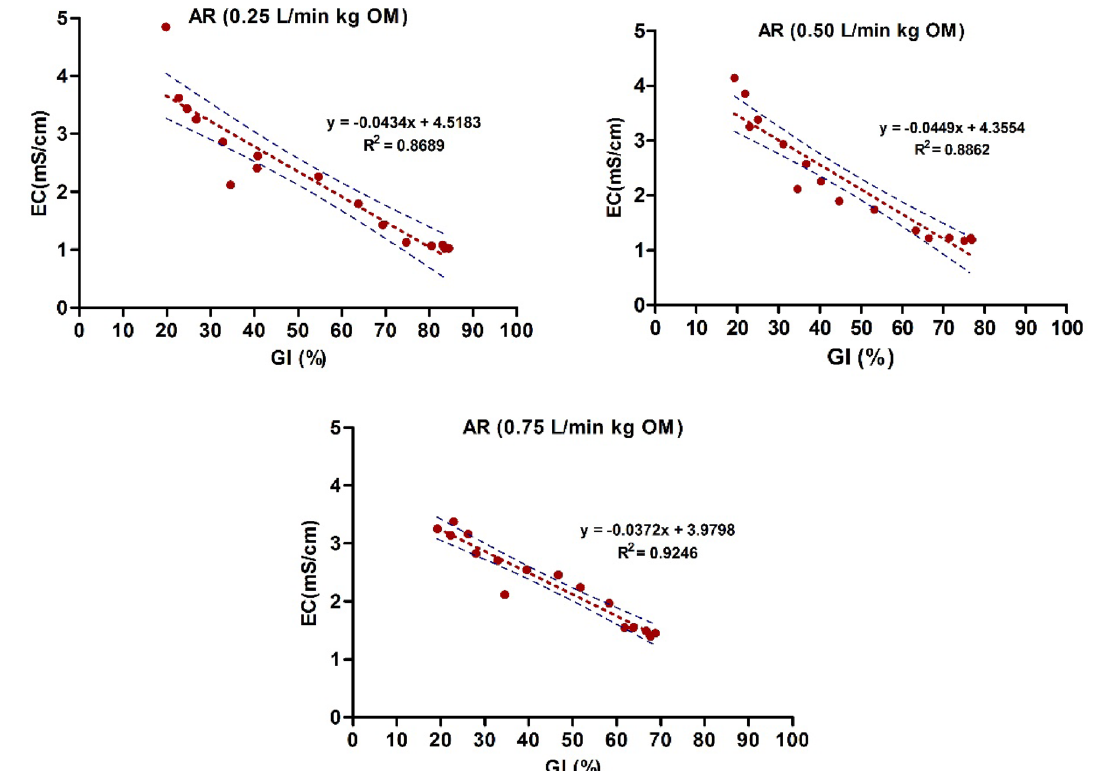
Fig. 7 Correlation between electrical conductivity (EC) and germination index (GI%) of